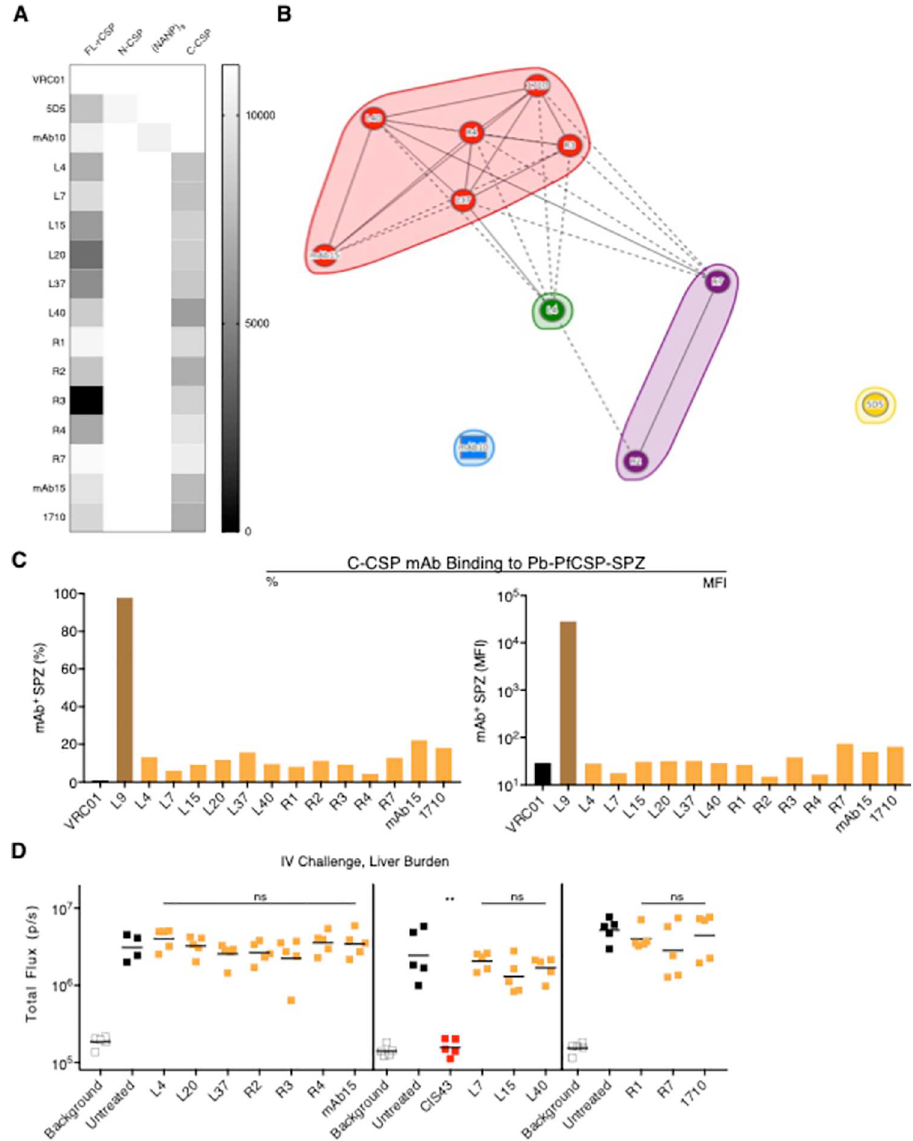
Fig 2. Binding and in vivo protection mediated by C-CSP-specific mAbs. (A) Heat map of area under the curve (AUC) values of thirteen C-CSP mAbs binding to FL-rCSP, N-CSP, 36mer peptide (NANP) 9 , and C-CSP by ELISA. VRC01 (anti-gp120 mAb), 5D5 (N-CSP mAb), and mAb10 (NANP-preferring repeat mAb) were respectively included as a negative isotype control, positive control N-CSP mAb, and positive control repeat mAb. Data were averaged from 2–3 independent experiments. (B) Epitope binning of C-CSP mAbs binding to FL-rCSP measured by SPR. All mAbs were tested as both ligands and analytes; several mAbs (L7, L15, L20, R1, mAb10) were excluded due to poor ligand and/or analyte binding to FL-rCSP. Solid lines indicate two-way competition; dotted lines indicate one-way competition. (C) Percentage (%) and median fluorescence intensity (MFI) of Pb-PfCSP-SPZ bound by 20 μ g/mL of indicated mAb, measured by flow cytometry. VRC01 and L9 (NVDP-preferring repeat mAb) were included as negative and positive controls. (D) Liver burden (bioluminescence; total flux, photons/sec) in mice 40 hours post- challenge (n = 5/group; line indicates geometric mean) mediated by 300 μ g of indicated mAbs administered 2 hours before IV challenge with 2,000 Pb-PfCSP-SPZ. CIS43 (NPDP-preferring repeat mAb) was included as a positive control. Vertical lines separate independent experiments. P- values were determined by comparing mAbs to untreated control using the Kruskal-Wallis test with Dunn’s post-hoc correction. �� , p < 0.01; ns (not significant), p > 0.05.